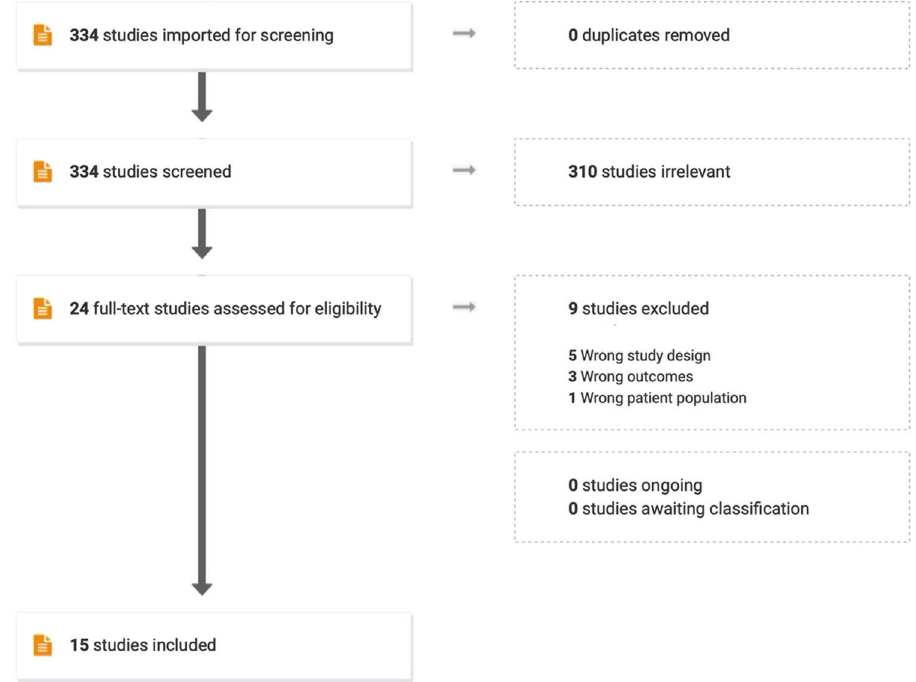
Fig. 1 Schematic of screening